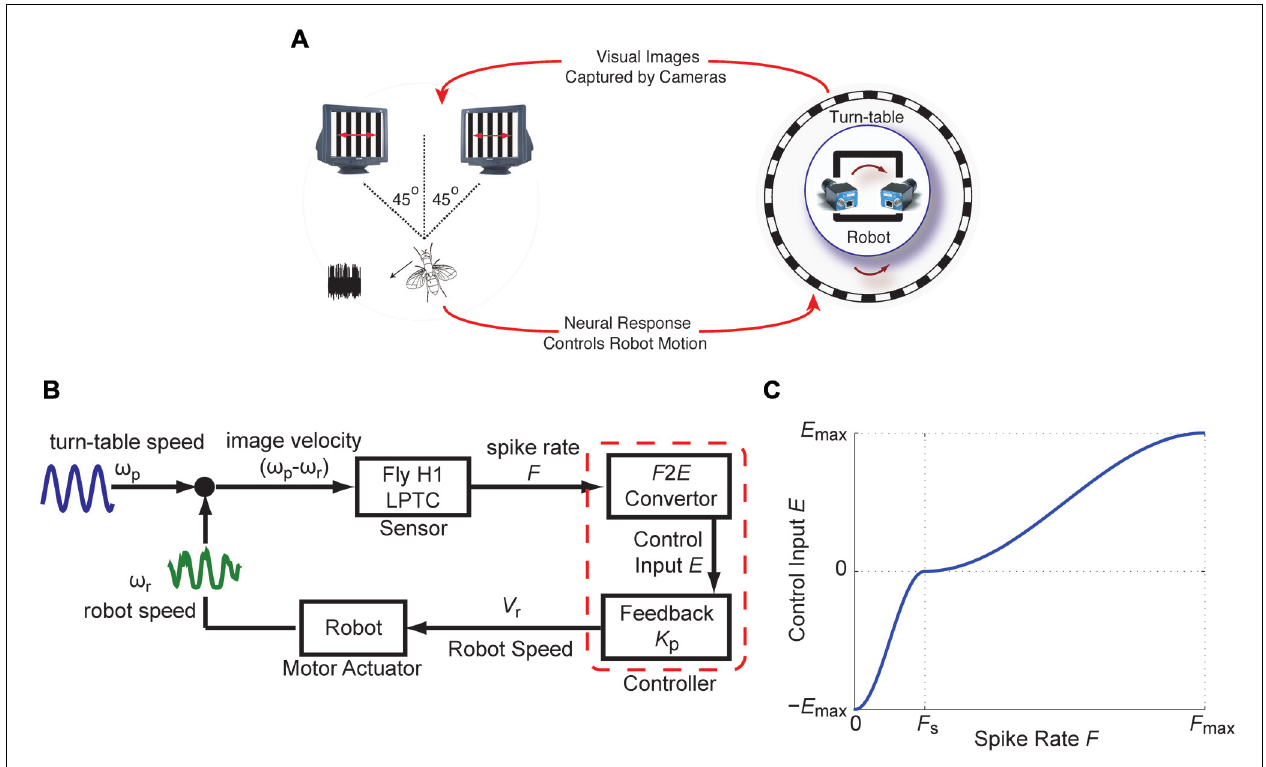
FIGURE 1 | The fly-robot interface (FRI) (A)A fly was placed in front of a visual display consisting of two high-speed CRT displays. Input to the two monitors were provided by two high-speed video cameras mounted on a mobile robot.The robot was positioned on a turntable placed inside a cylindrical arena lined with vertically oriented grating pattern. Robot and turntable movements were limited to rotations around the vertical axis.Visual motion as a result of the rotation of the turntable was captured by the cameras. Electrophysiology recordings from the H1-cell were used to control